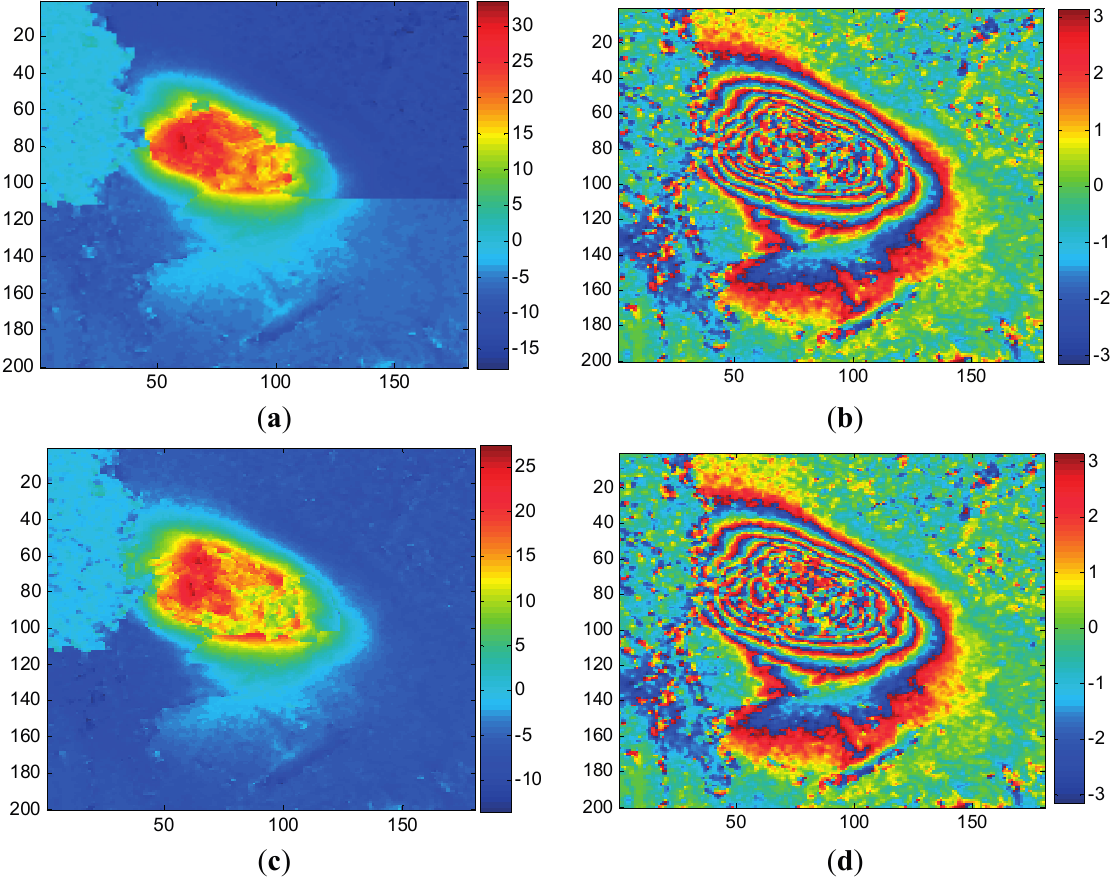
Figure 6. Results based on MCF method: ( a ) unwrapped map with pre-filtering filter threshold set at 0.1; ( b ) rewrapped map of ( a ); ( c ) unwrapped map with adaptive filter threshold set at 0.25; ( d ) rewrapped map of ( c